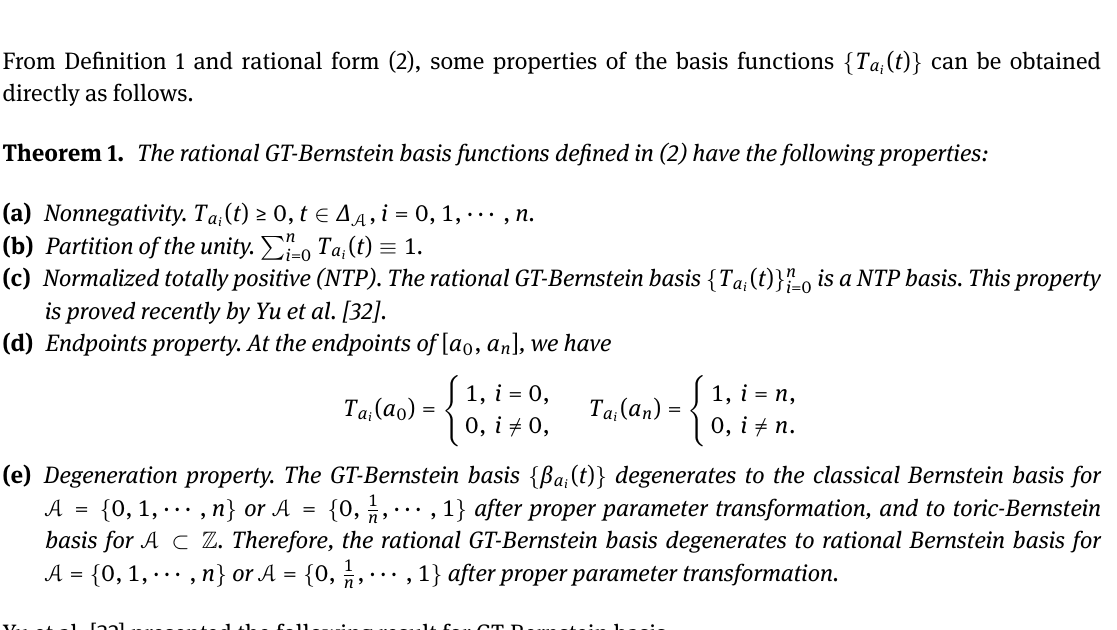
Figure 4: Effect of knot changing on GT-Bernstein